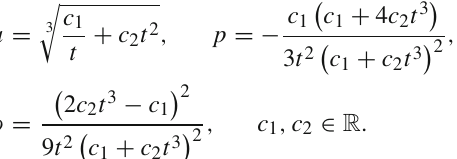
of the kinetic term while the rest of the physical fields stays real-valued – is called